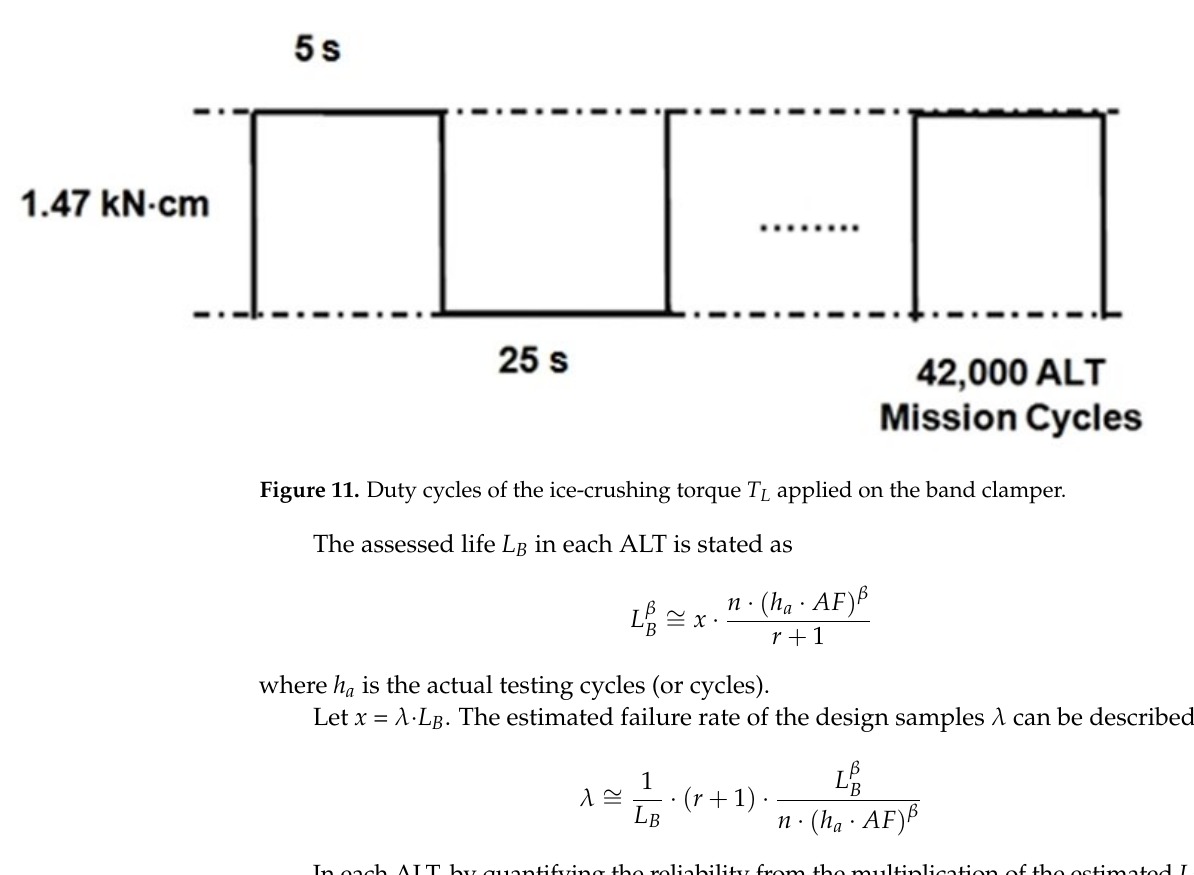
Figure 10. Apparatus utilized in parametric ALT. ( a ) ALT apparatus; ( b ) controller.